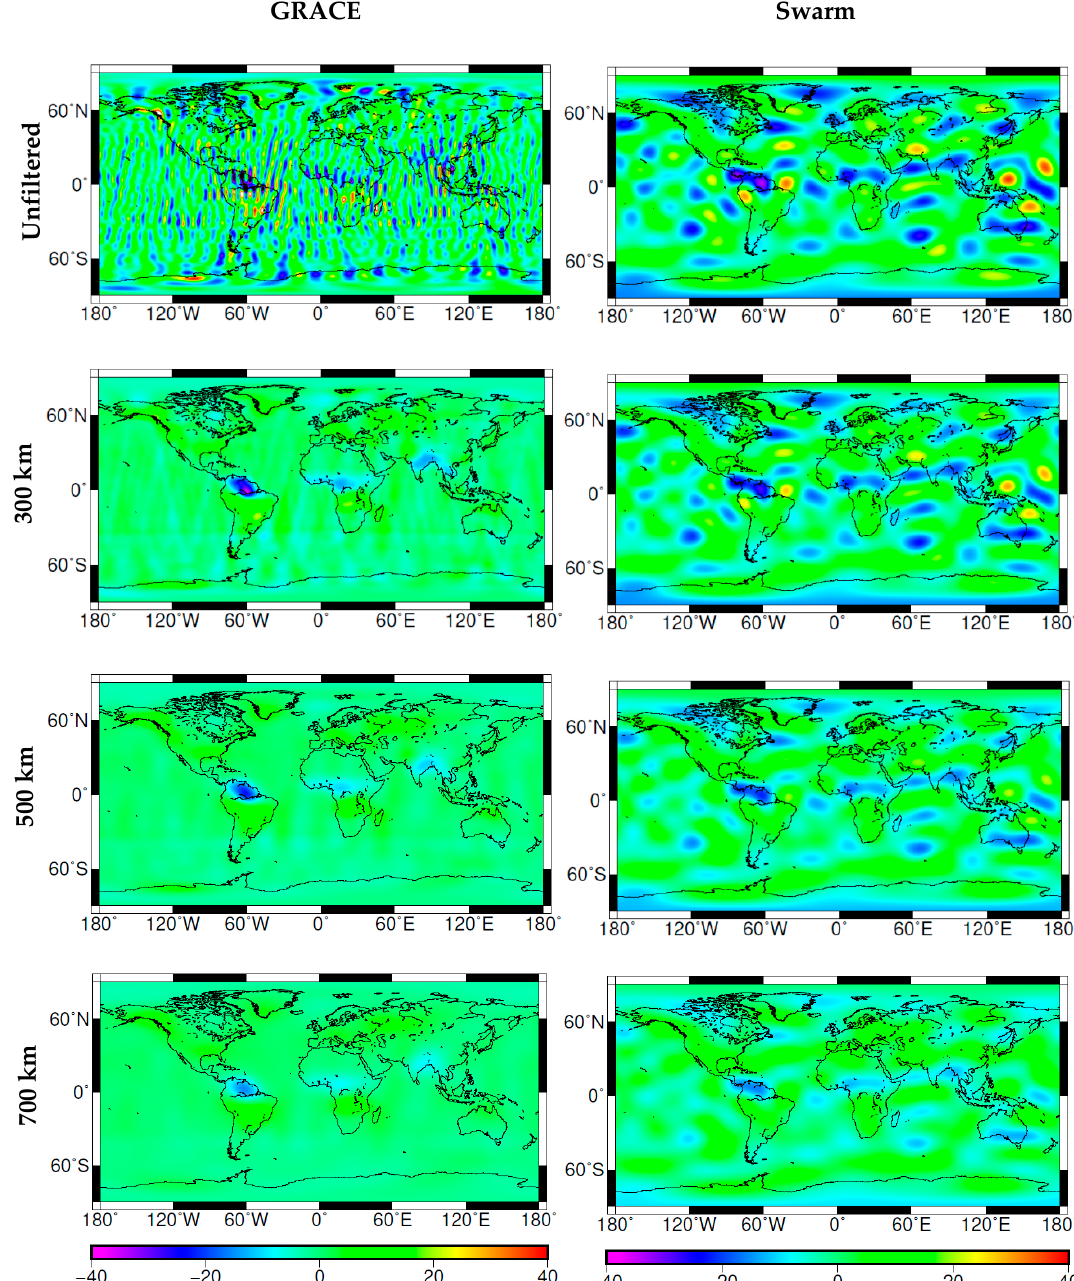
Figure 7. Monthly surface mass variation on March 2016 with unfiltered (top row), 300 km fan filter (second row), 500 km fan filter (third row) and 700 km fan filter (bottom row) from GRACE (left column) and Swarm (right column).